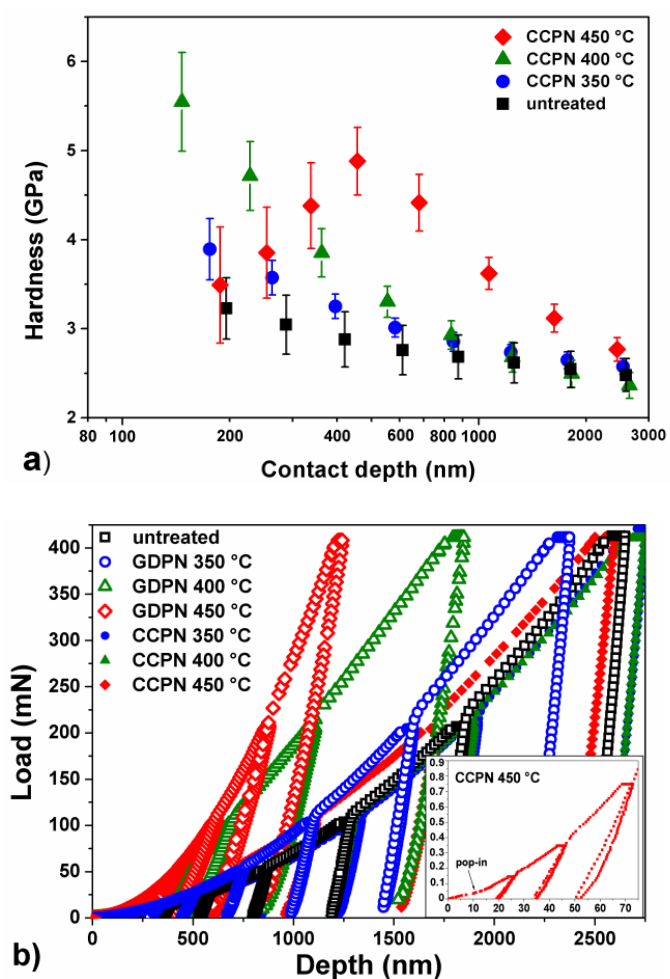
Figure 12. ( a ) Hardness profiles of untreated and CCPN-nitrided samples and ( b ) loading curves for all samples. The inset shows a pop-in event in the loading curve of the CCPN 450 °C sample.